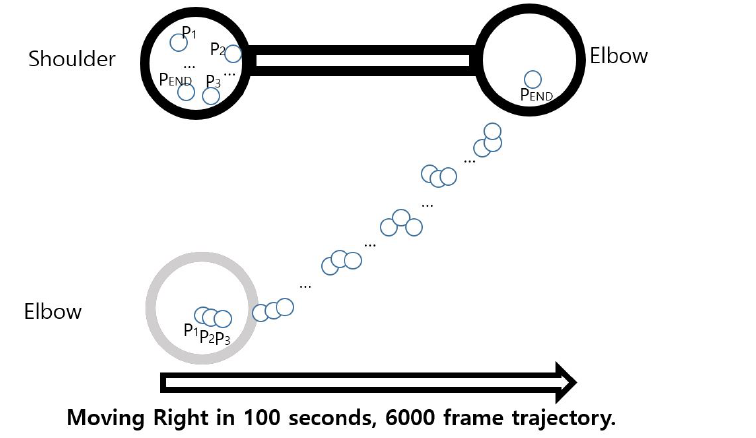
Figure 8. Locus of stopped shoulder and micro-movement of elbow points through 600 frames. Looking at the difference between shoulder, but a very large difference in the case of the elbow. This is general evidence that VSM would detect a natural error in a static target and the actual movements of a